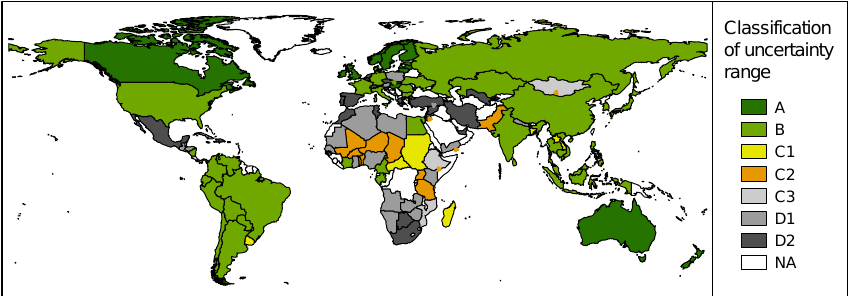
Figure 5. Classification of countries for baseline conditions following the decision tree outlined in Fig. 2. Result values for current and future calculations for all GCMs and RCPs are published on figshare (Lissner et al., 2014a).